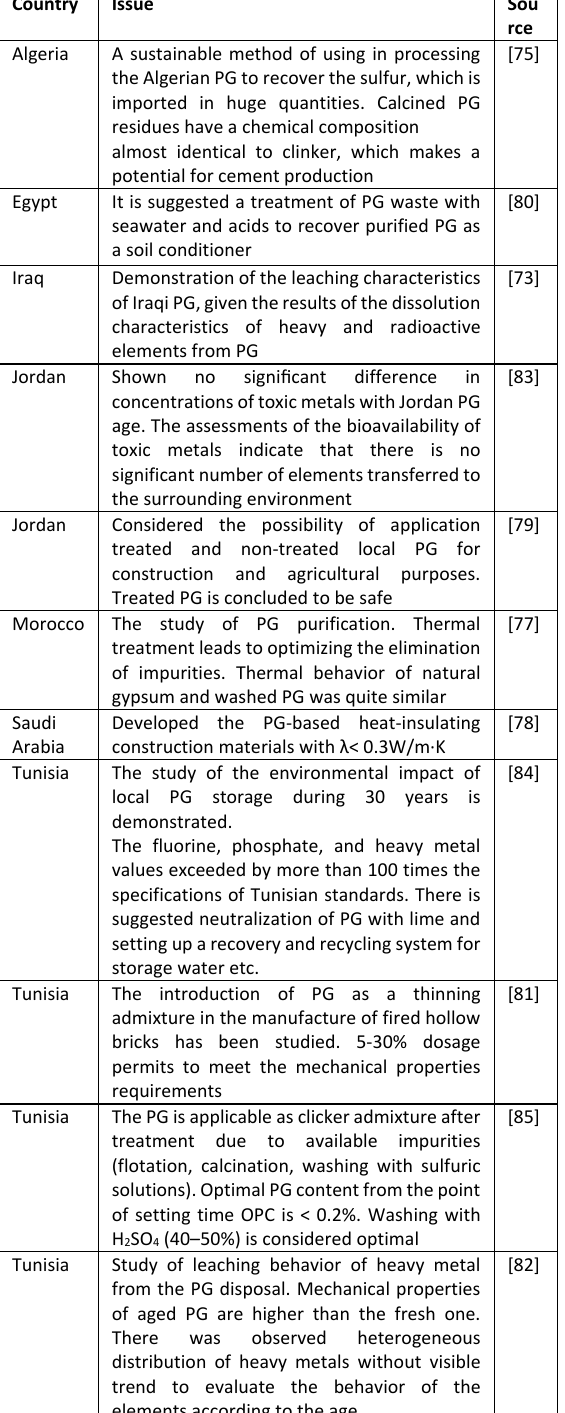
Table 2. Review of accumulated data of PG application in the region by